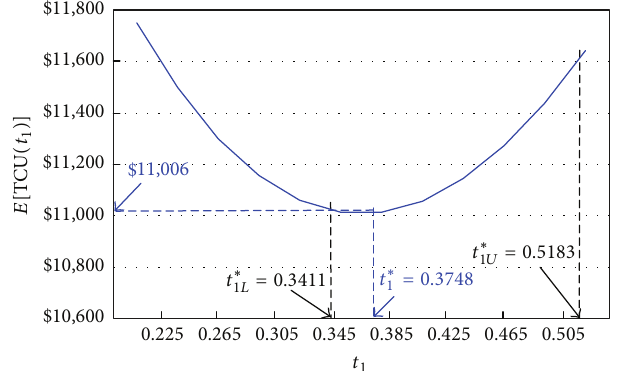
Figure 6: The behavior of 𝐸[ TCU (𝑡 1 )] in connection with the production run time 𝑡 1 in the proposed model